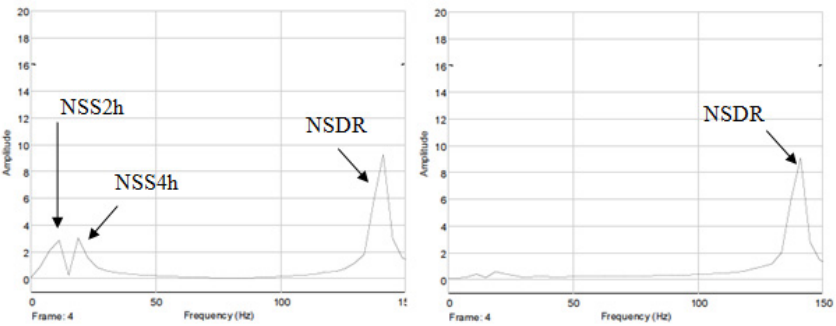
Figure 21. Frequency analysis of position signal prior to and after NSS filtering.